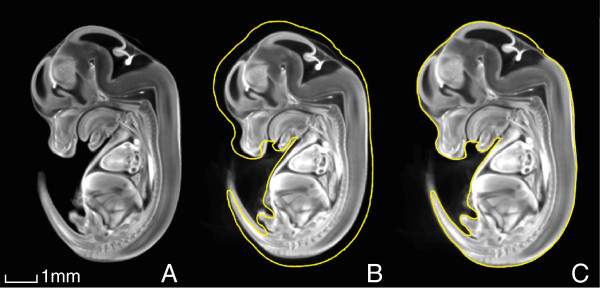
Embryonic size difference at E13.5. (A) A consensus average of all E13.5 embryos constructed using the SD and KD OPT embryo images (N = 59), followed by separate averages of (B) all SD (N = 27) and (C) all KD (N = 32) E13.5 embryos. The outline of the KD embryo is traced in yellow in (b) to illustrate the overall size difference compared with the SD embryo.